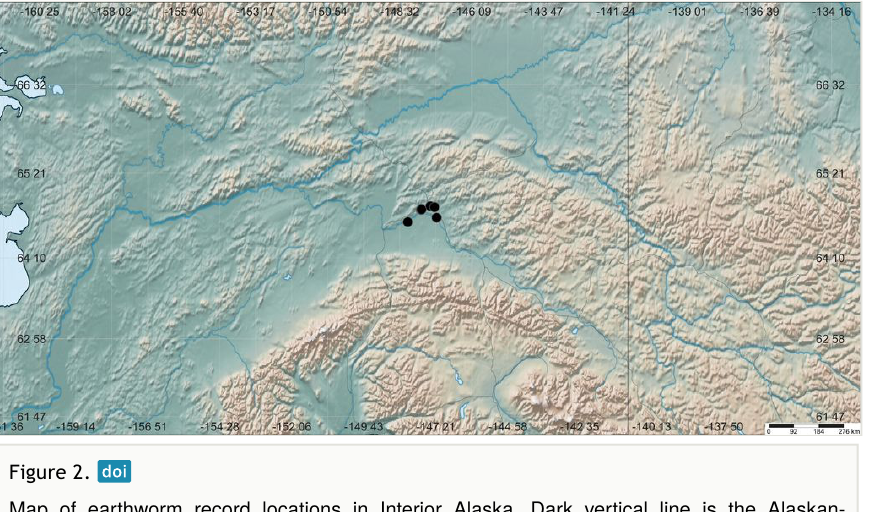
Map of earthworm record locations in Interior Alaska. Dark vertical line is the Alaskan- Canadian border. Map made using Shorthouse